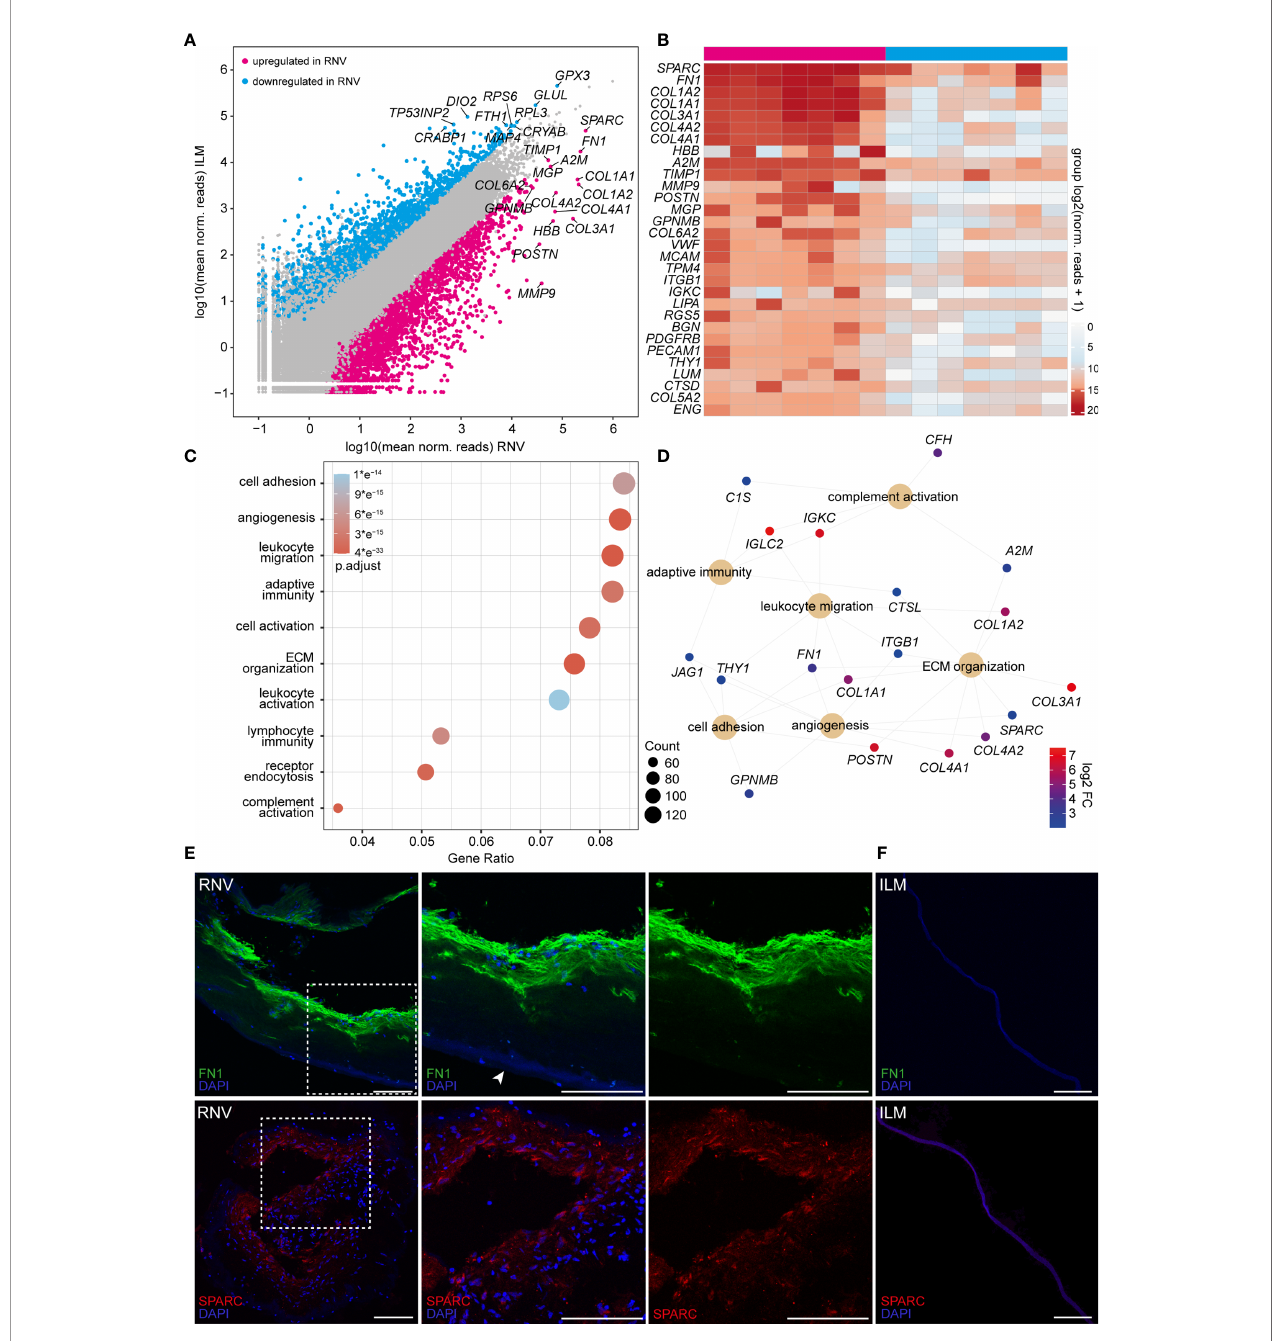
FIGURE 3 | High-throughput sequencing identi fi es a variety of pro-angiogenic, in fl ammatory and pro- fi brotic factors enriched in retinal neovascularization (RNV) membranes. (A) Readplot of differentially expressed genes in RNV (upregulated genes in magenta, downregulated genes in blue, not differentially expressed genes in grey; the most strongly expressed genes from each group are labeled). (B) Heatmap of the most prominent transcripts in human RNV membranes according to the mean expression. Color coding of the transcripts according to the number of normalized counts (log2-scaled). (C) Most signi fi cant Gene ontology (GO) biological process clusters of the signi fi cantly upregulated mRNA transcripts in RNV. Color coding of the dots according to the adjusted p value, size of the dots according to the count of transcripts associated with the respective GO term. ECM, extracellular matrix. (D) Cnetplot of the top expressed genes in the most disease-relevant GO biological processes. Color coding of the transcripts according to the log 2 fold change of mean expression. (E) Immunohistochemical staining for FN1 (upper panel) and SPARC (lower panel) in RNV samples. Higher magni fi cation of the sections within the dashed white square is shown to the right. Arrowhead points to the ILM, adjacent to the RNV. Nuclei are counterstained with DAPI. (F) Immunohistochemical staining for FN1 (upper panel) and SPARC (lower panel) in internal limiting membrane (ILM) samples. Nuclei are counterstained with DAPI. Scale bars correspond to 100 m